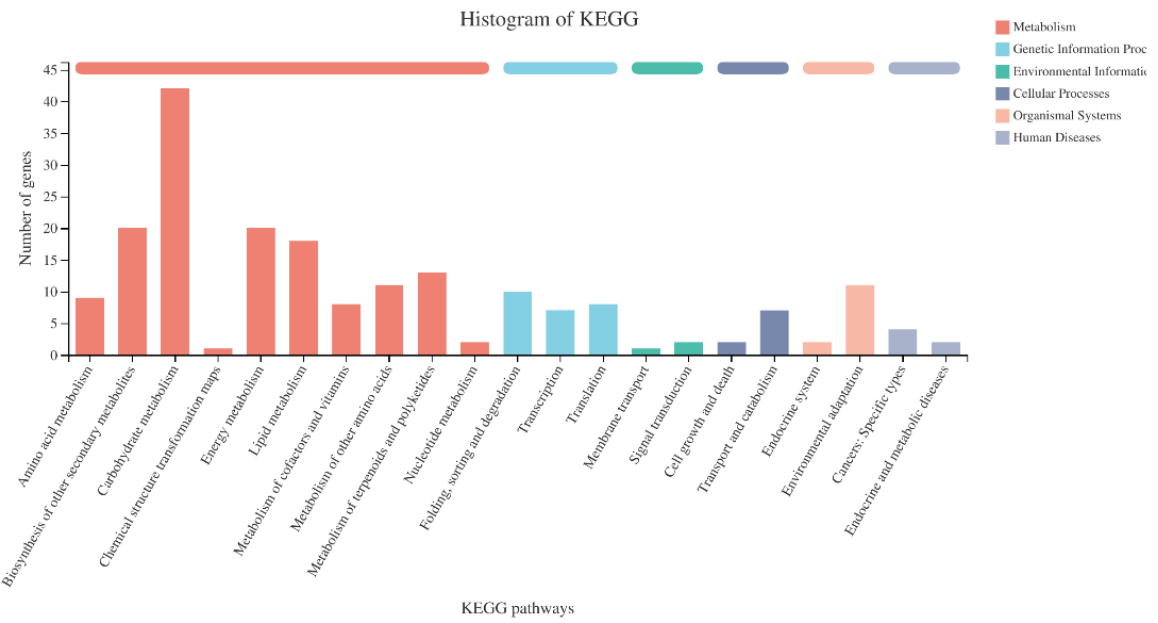
Figure 7. Classification statistics of differentially expressed genes in the KEGG pathway. The abscissa is the name of the KEGG metabolic pathway; the ordinate is the number of genes annotated to this pathway.